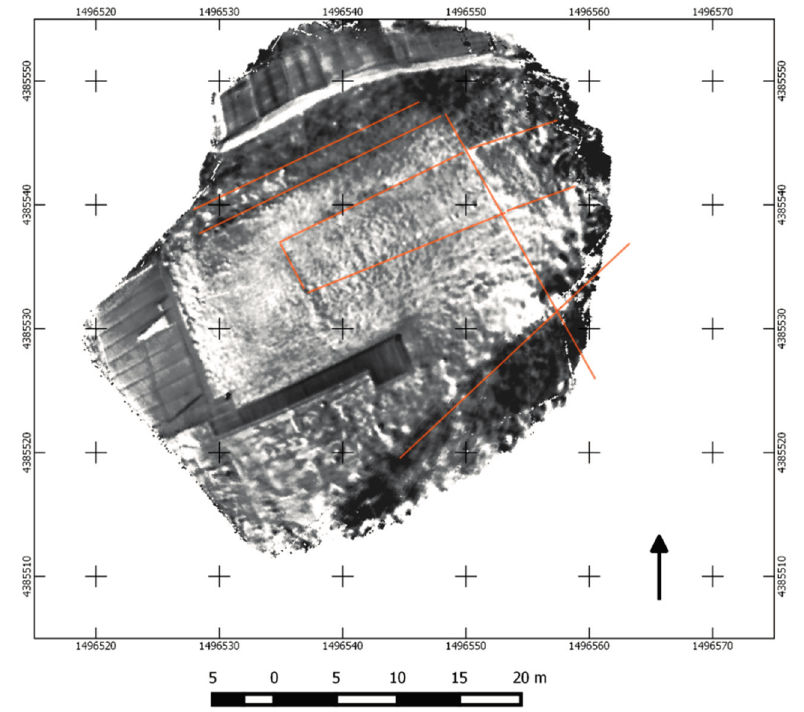
Figure 14. The NTG map, after histogram enhancing of middle range values, shows weak, but existing correspondences with previous building alignments (see Figure 11a) in the north-central sector. Other darker regions are shown.